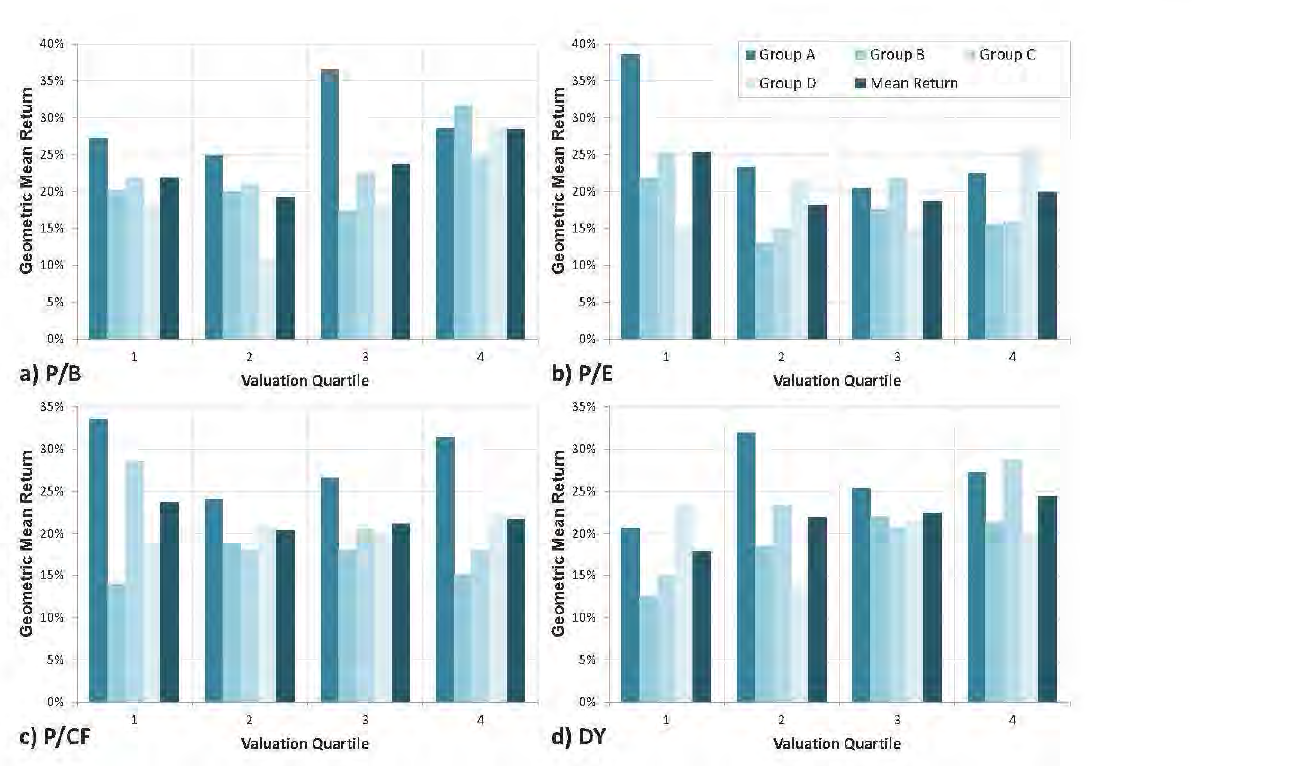
Figure 6: Portfolio returns based on valuation multiples to illustrate the value effect across all firm sizes, 1999-2012 for a) P/B, b) PIE, c) P/CF and d)